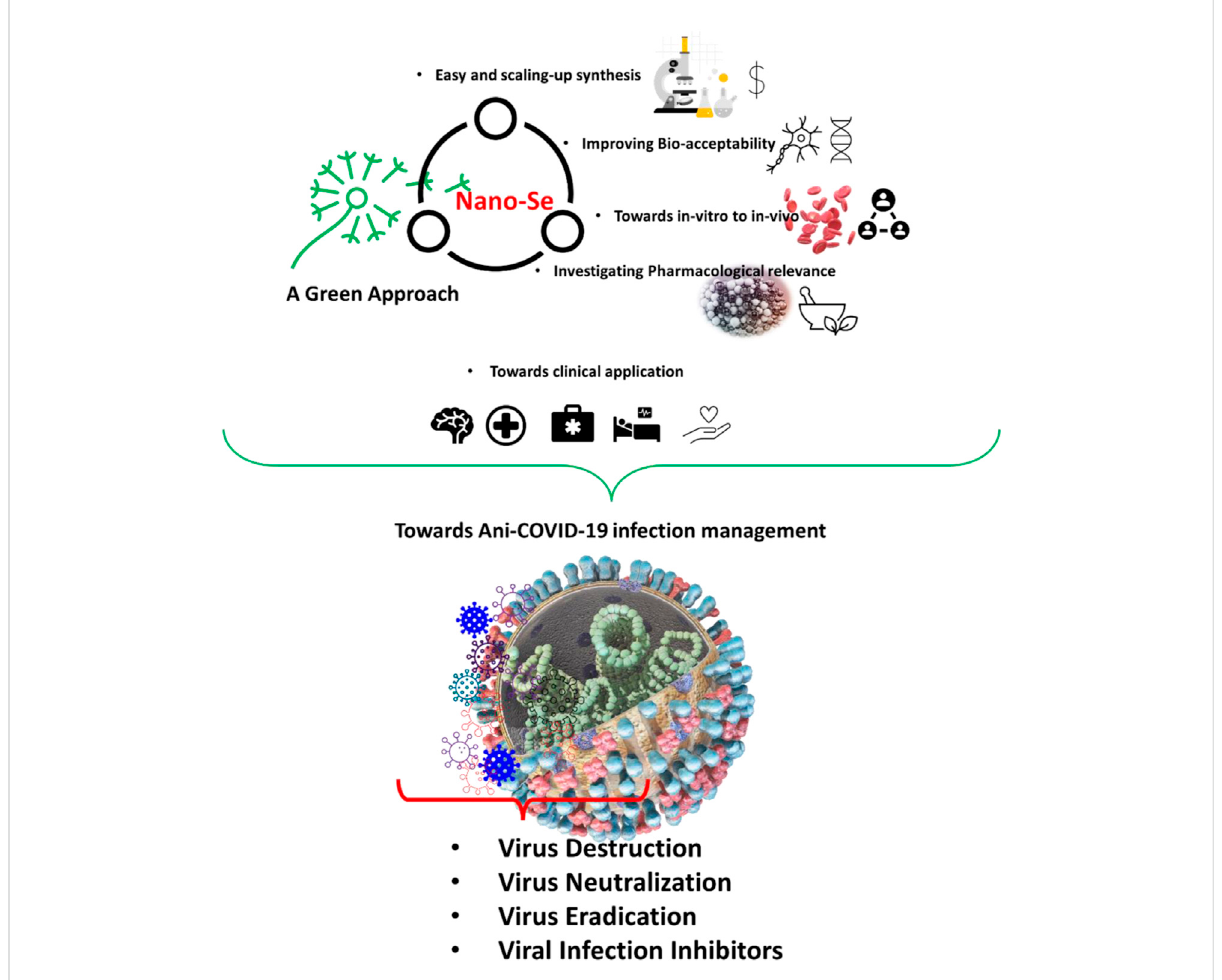
FIGURE 10 Prospects of Nano-Se toward using a green approach for ef fi cient biomedical application, especially with a focus on tackling SARS-CoV-2 to manage COVID-19 infection management.